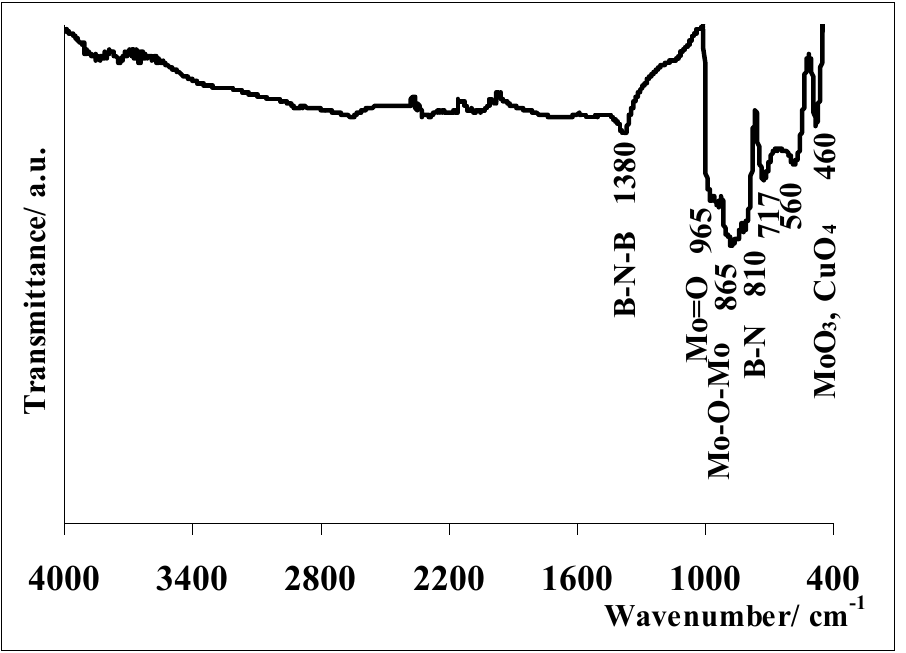
Figure 3. The IR spectrum of the product obtained from CuO + MoO 3 mixture cooled down from 1023 K, V h = 300 K min − 1 .